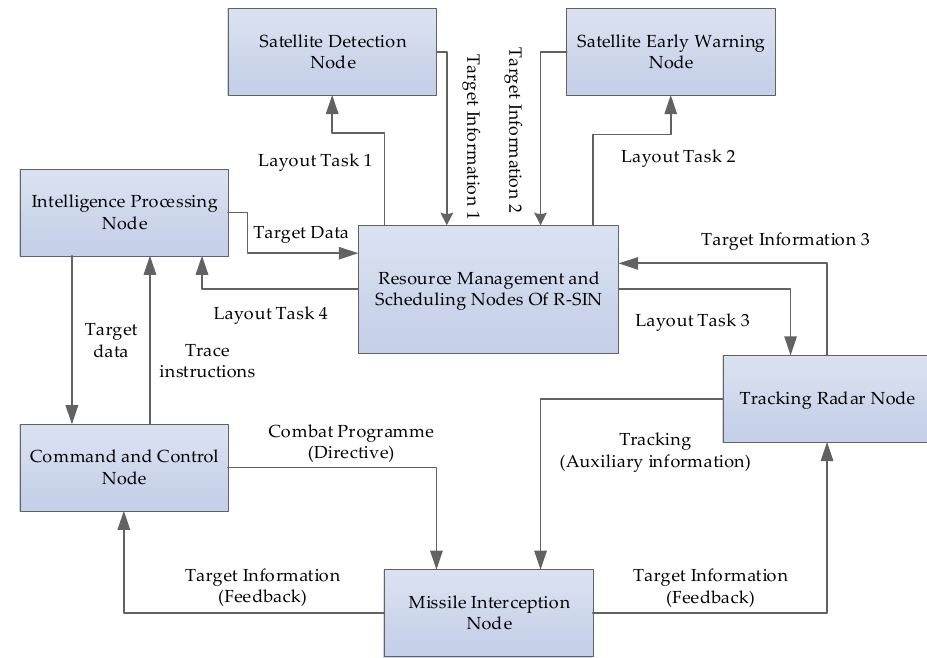
Figure 10. The R-SIN combat node connection, and the description model supporting the anti-missile tasks.